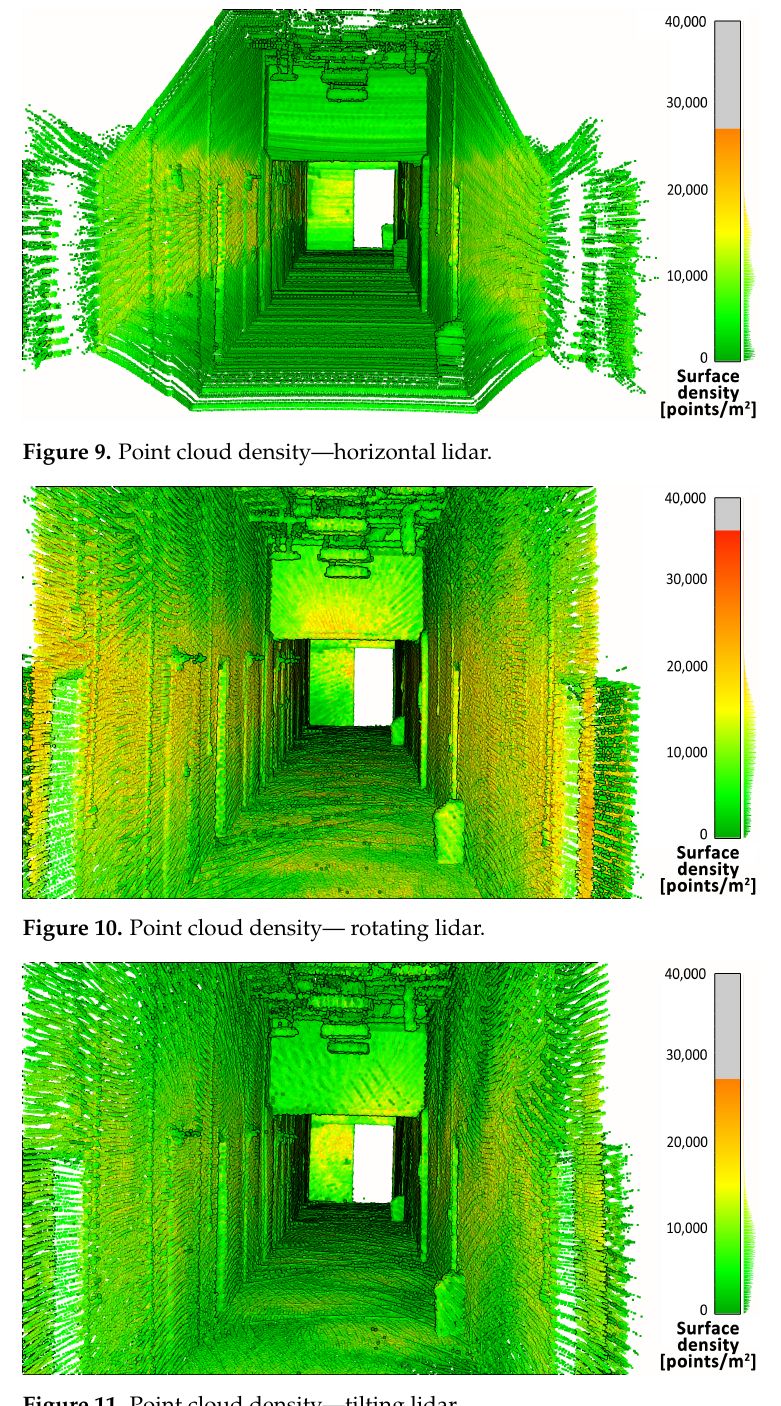
Figure 11. Point cloud density—tilting